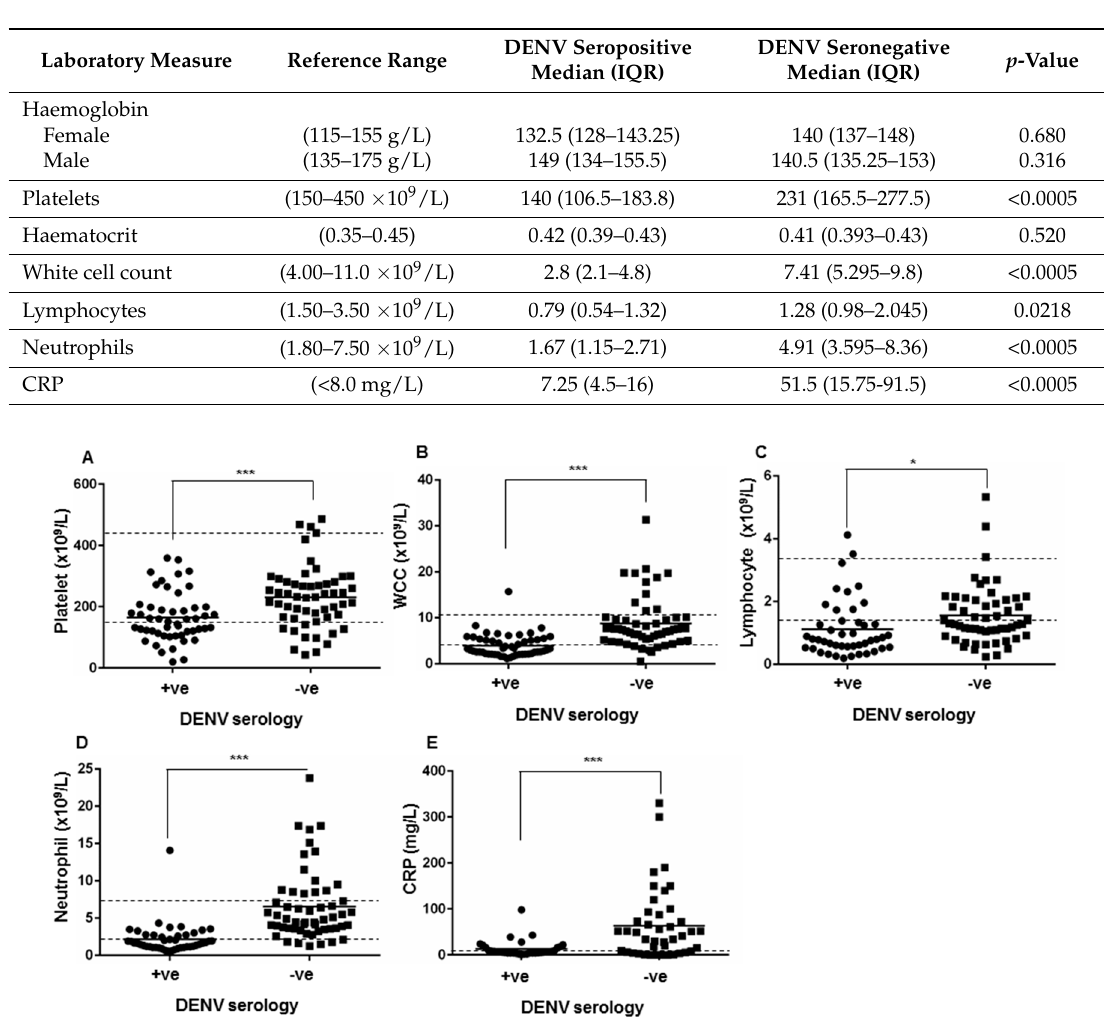
Figure 1. Comparison of ( A ) platelet count; ( B ) white cell count (WCC); ( C ) lymphocyte count; ( D ) neutrophil count and ( E ) C-reactive protein (CRP) levels; in blood from patients who were positive (+ve, n = 49) or negative ( − ve, n = 51) by DENV serology. * = significantly different, p < 0.05; *** p < 0.0005, Students t -test. Clinical reference range is indicated by the dashed lines. 3.4. Reliable Detection of DENV by RT-PCR Requires Multiple PCR Approaches and Detects DENV-1, -2